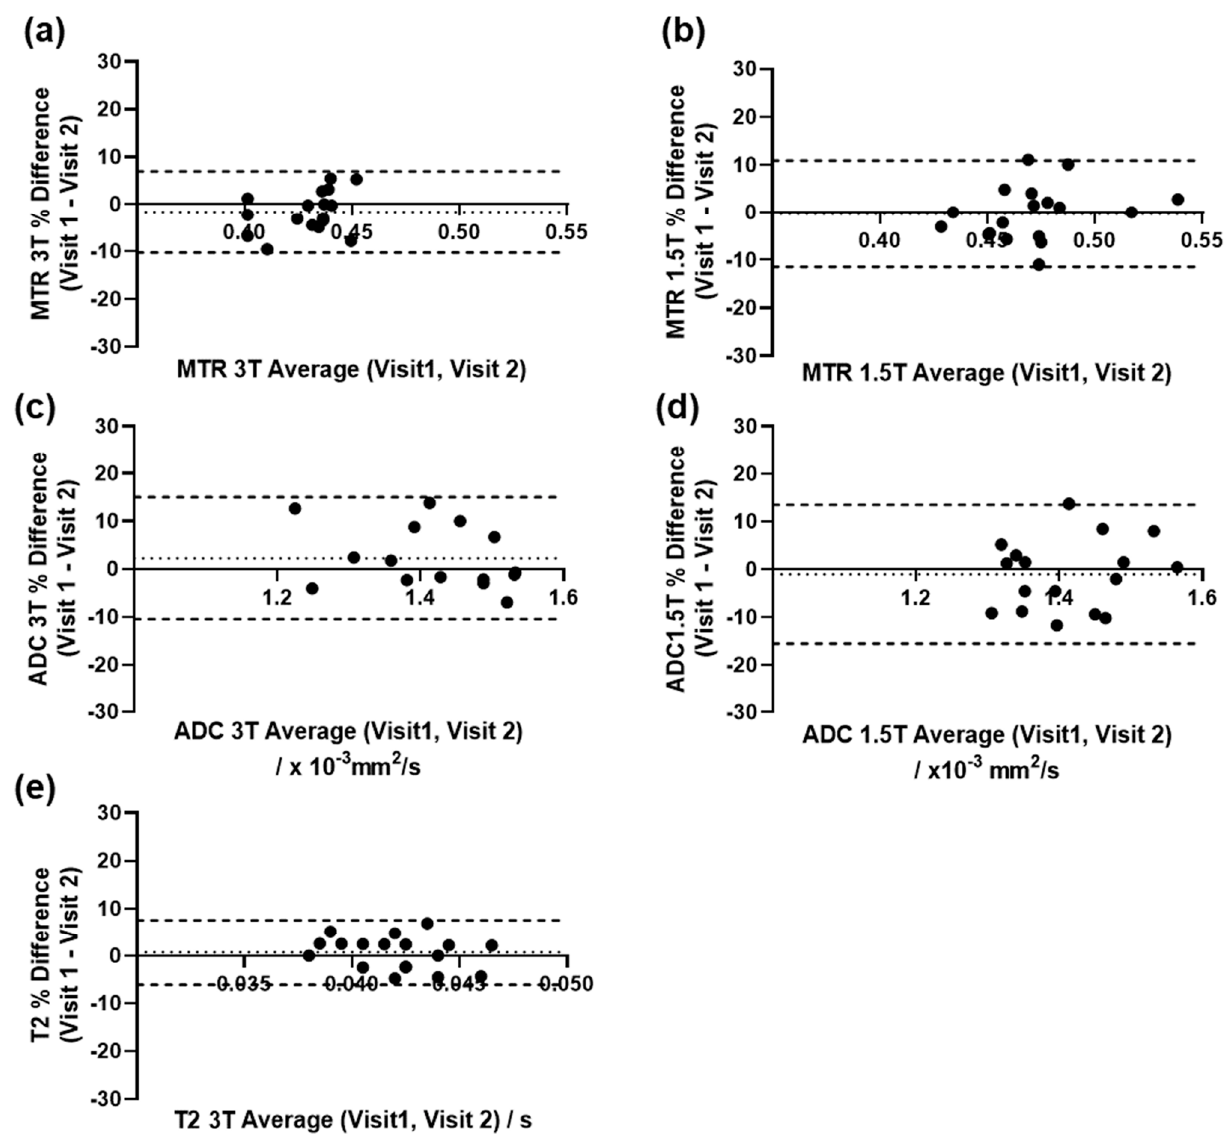
Figure 4. Bland–Altman plots for repeatability muscle data from 3 T ( a , c , e ) and 1.5 T ( b , d ). Data shown as % change from average. Limits of agreement are shown as dashed lines and bias is shown as dotted line .